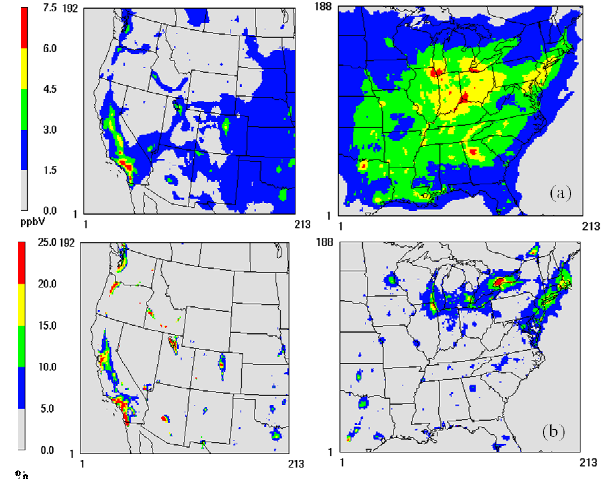
Fig. 4. (a) Monthly mean (daytime) NO z with CB05-Base (b) per- cent increases in mean NO z between CB05-TU and